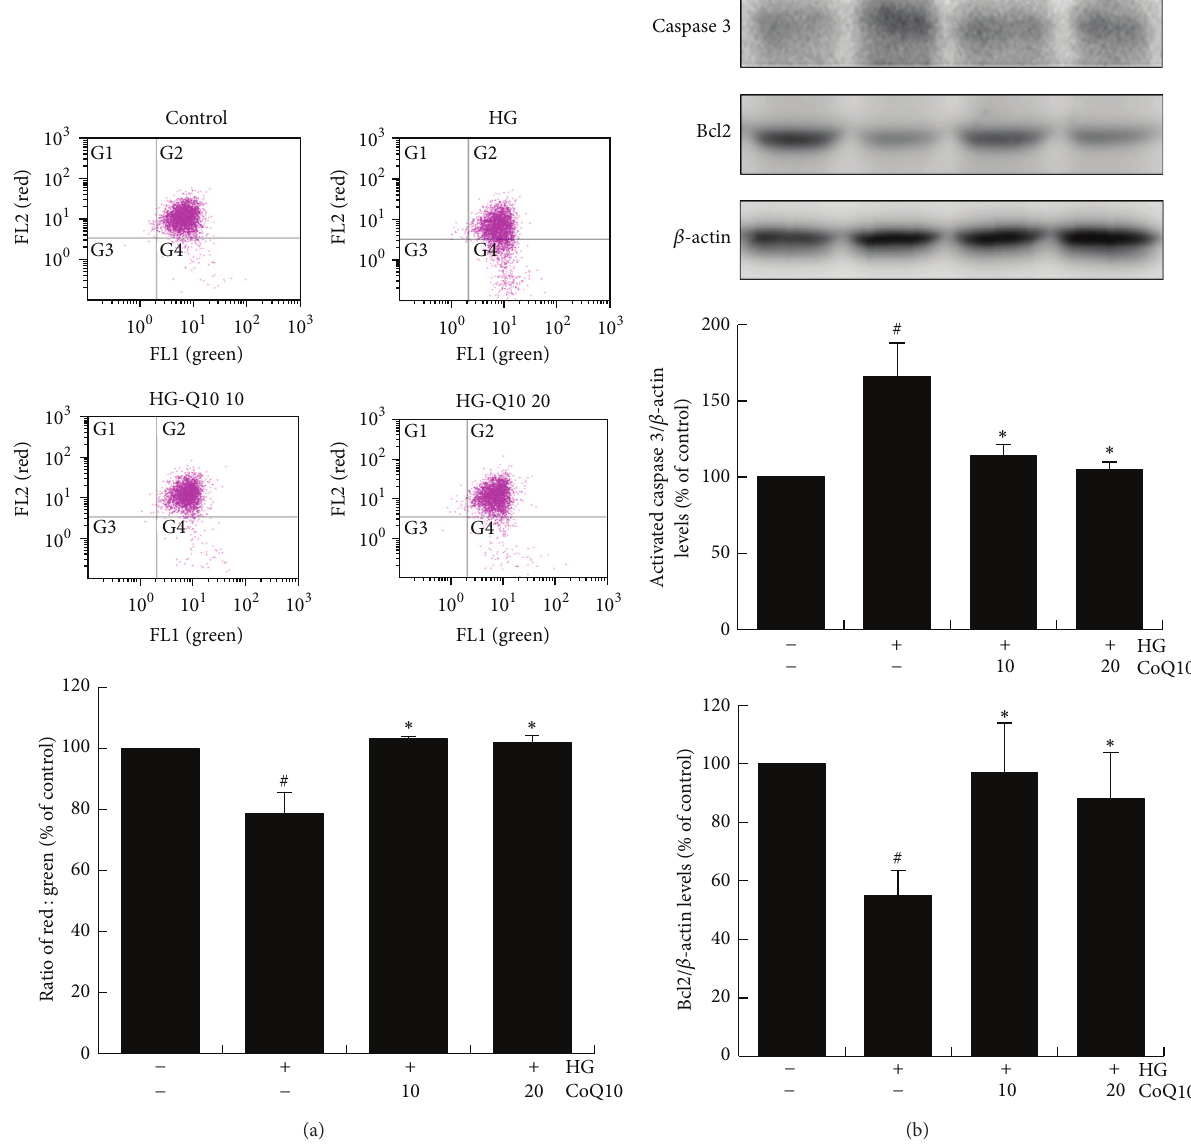
Figure 3: Effect of CoQ10 on EPC apoptosis under high glucose conditions. EPCs were incubated with CoQ10 (10 𝜇 M) for 24 hrs in high glucose medium. (a) Mitochondrial apoptosis was detected by JC-1 assay by flow cytometry. Loss of mitochondrial membrane potential ( ΔΨ m ) was performed by the change in JC-1-derived fluorescence from red to green. The ratio of red/green fluorescence represented ΔΨ m in EPCs. (b) Expression of activated-caspase 3 and Bcl-2 protein levels were assessed by western blot analysis. Data are mean ± SE; 𝑛 = 4 ; # 𝑃 < 0.05 versus control (5 mM glucose); ∗ 𝑃 < 0.05 versus high glucose